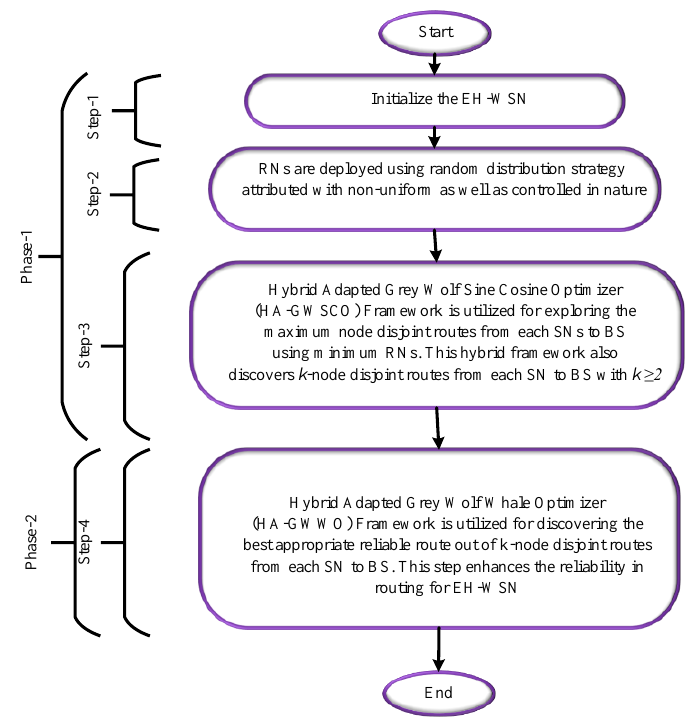
Figure 1. A proposed framework consisting of two